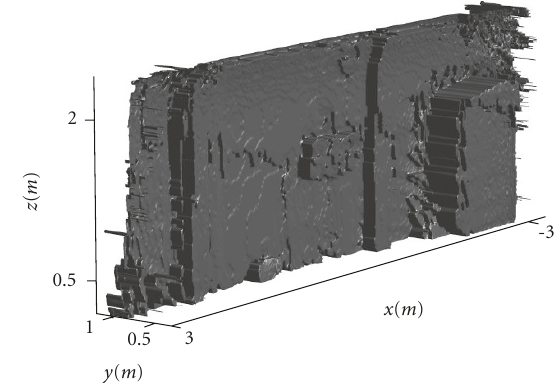
Figure 3: Surface presentation of the acoustic image of the corridor wall.